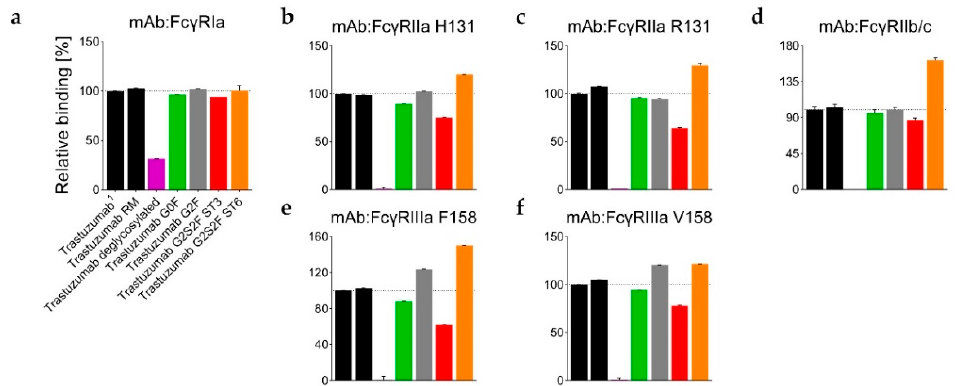
Figure 4. ( a – f ) Relative Fc γ R binding (%) of trastuzumab (glyco-)variants, as normalized with 1 trastuzumab starting material. Binding affinities were measured by surface plasmon resonance (SPR) technology; n = 3.